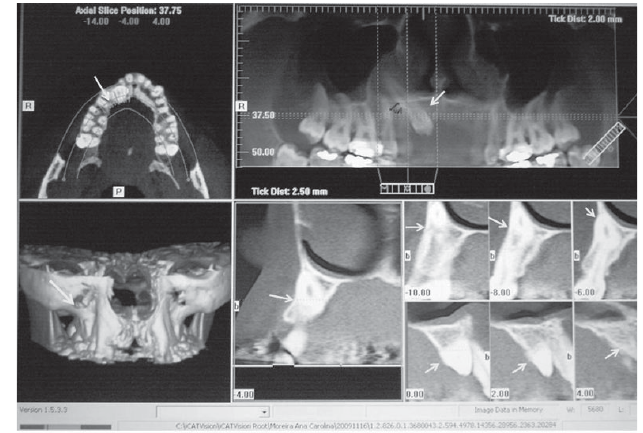
Fig. 6: Maxillary computed tomography